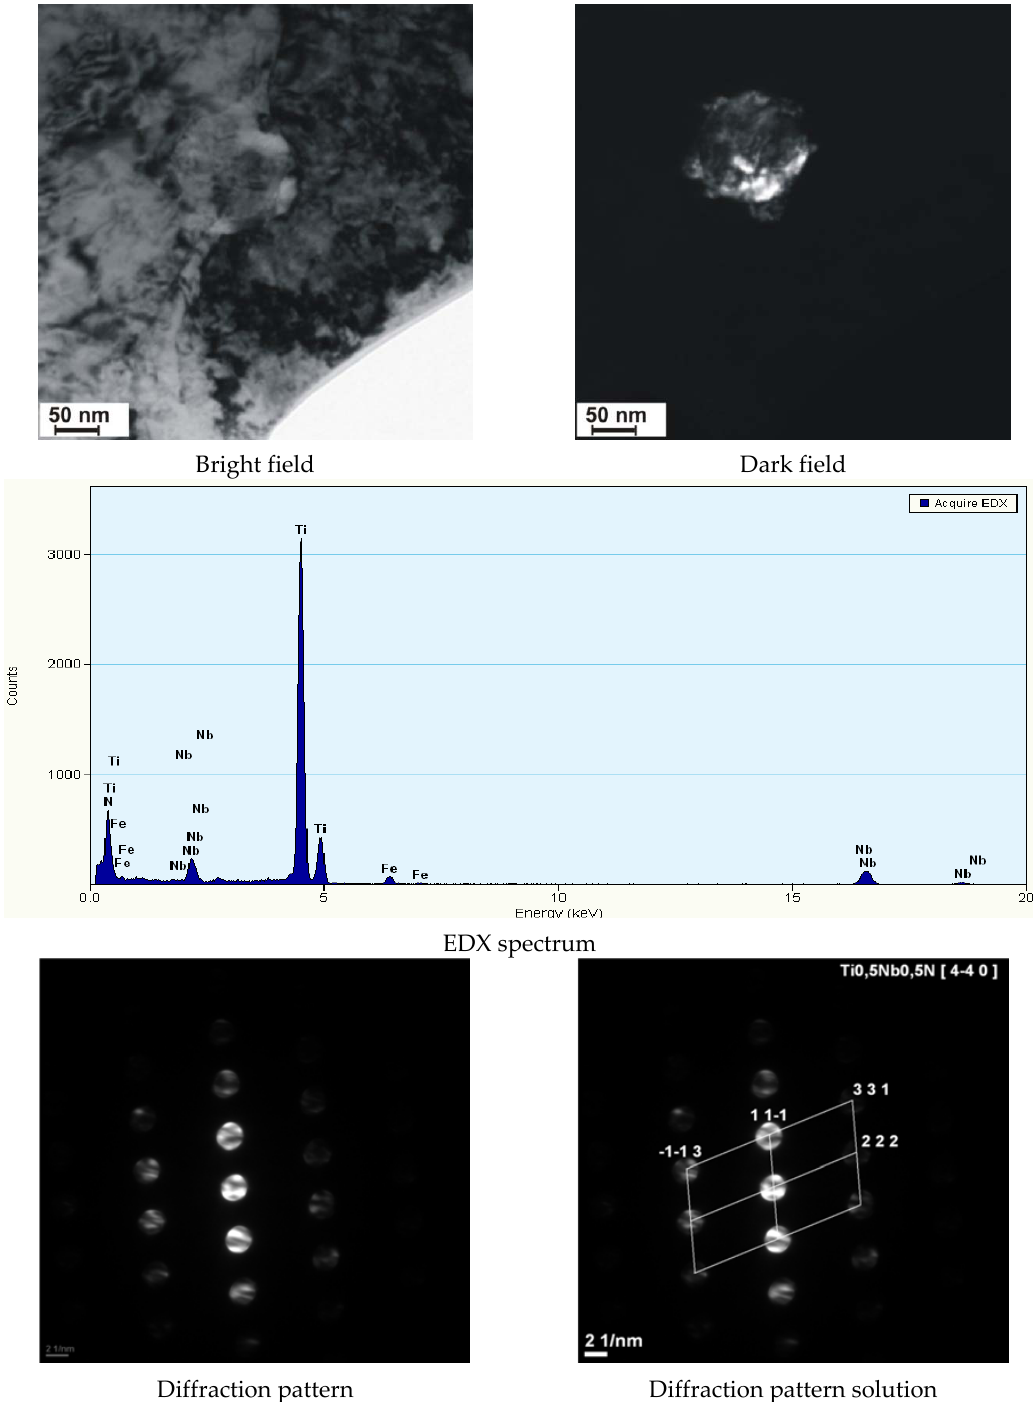
Figure 15. Precipitate of the (Ti,Nb)N nitride along with the fine spherical hardening precipitates in the weld of steel S700MC, made using the laser beam.